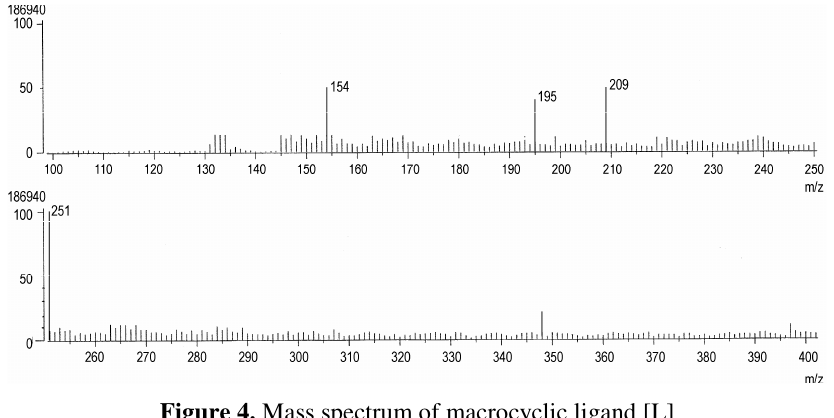
Figure 4. Mass spectrum of macrocyclic ligand [L]